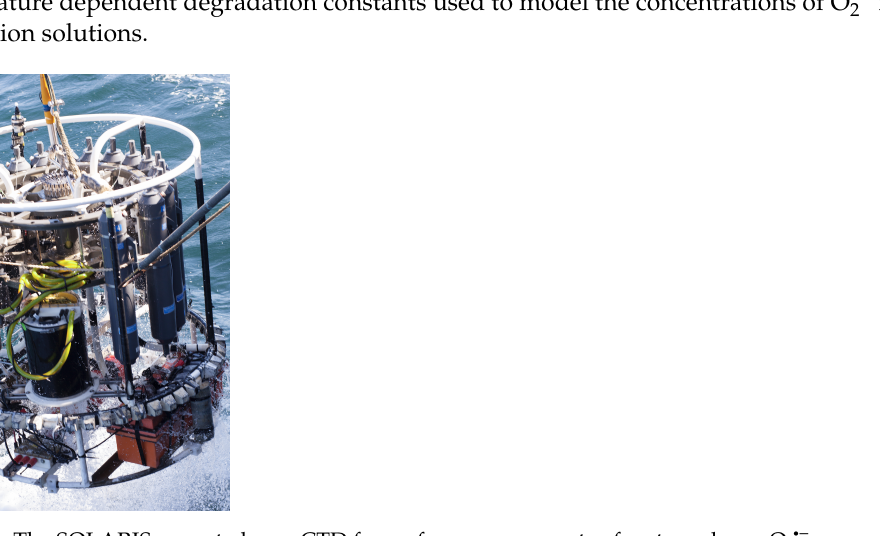
Figure 5. The SOLARIS mounted on a CTD frame for measurements of water column O – 2 .